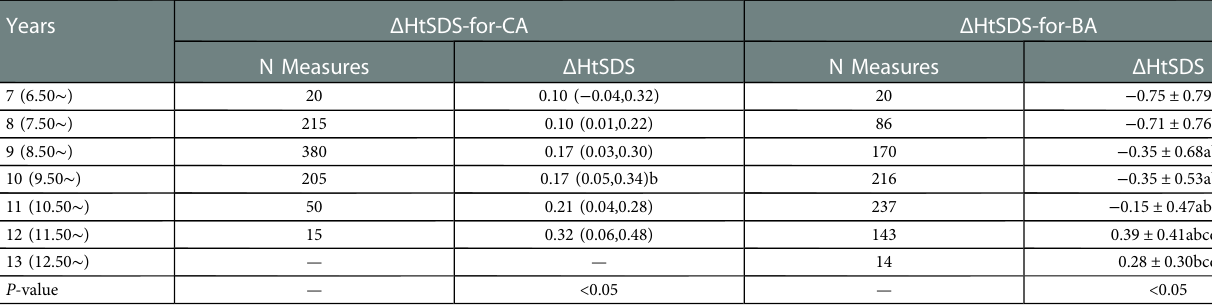
TABLE 4 Δ HtSDS-for-CA and Δ HtSDS-for-BA of EP